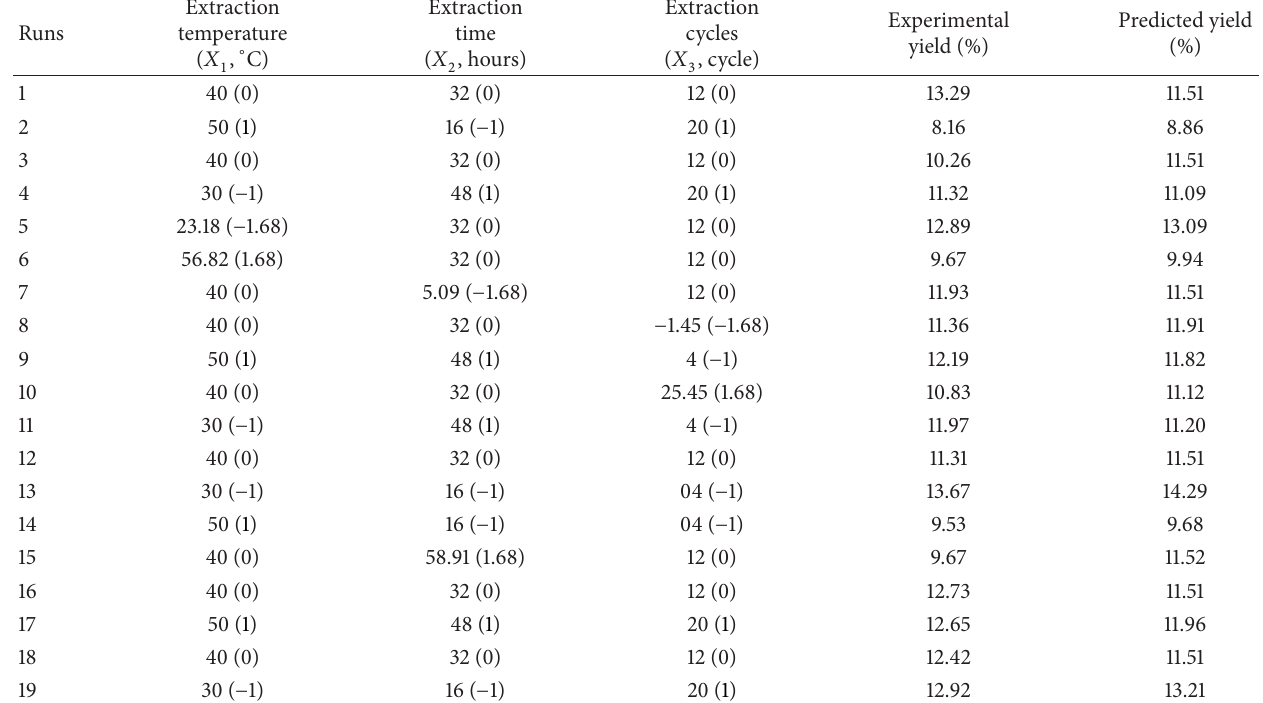
Table 2: Central composite design by RSM program for optimization of extraction conditions with experimental and their corresponding predicted